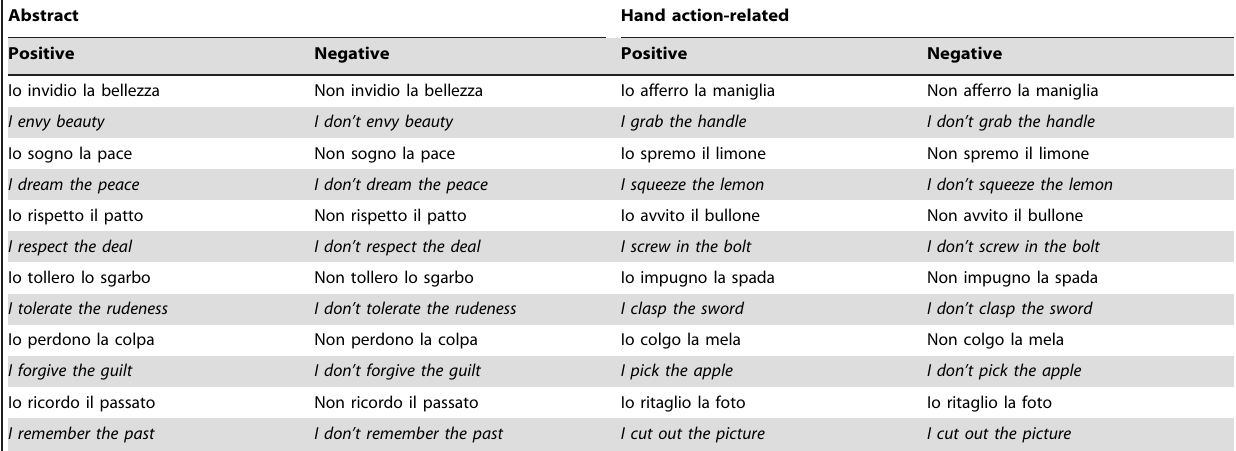
Table 1. List of all experimental stimuli.